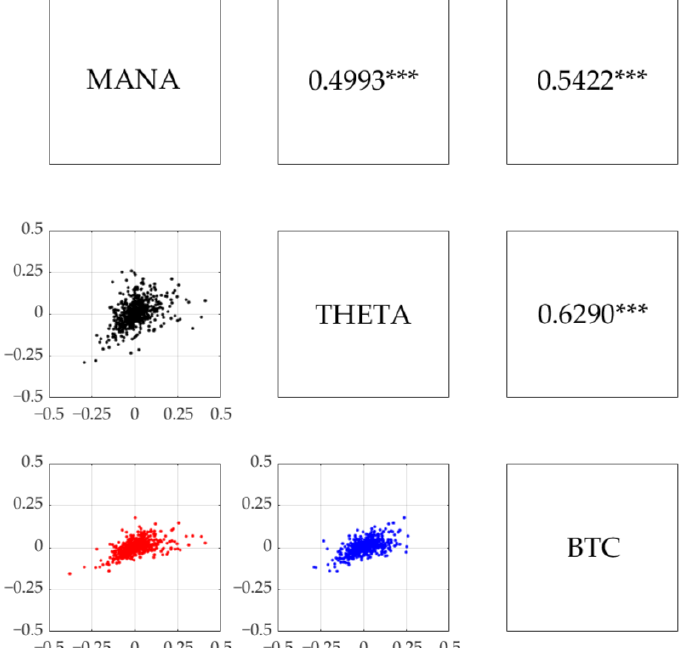
Figure 3. Scatter and correlation plots between metaverse cryptocurrencies and Bitcoin returns. The asterisk *** indicates statistical significance at the 1%